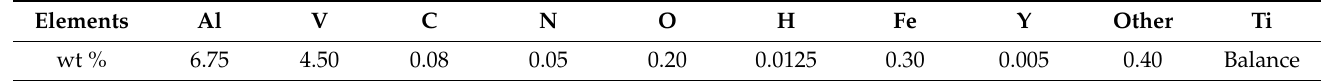
Table 1. Chemical composition of the Ti-6Al-4V workpiece.